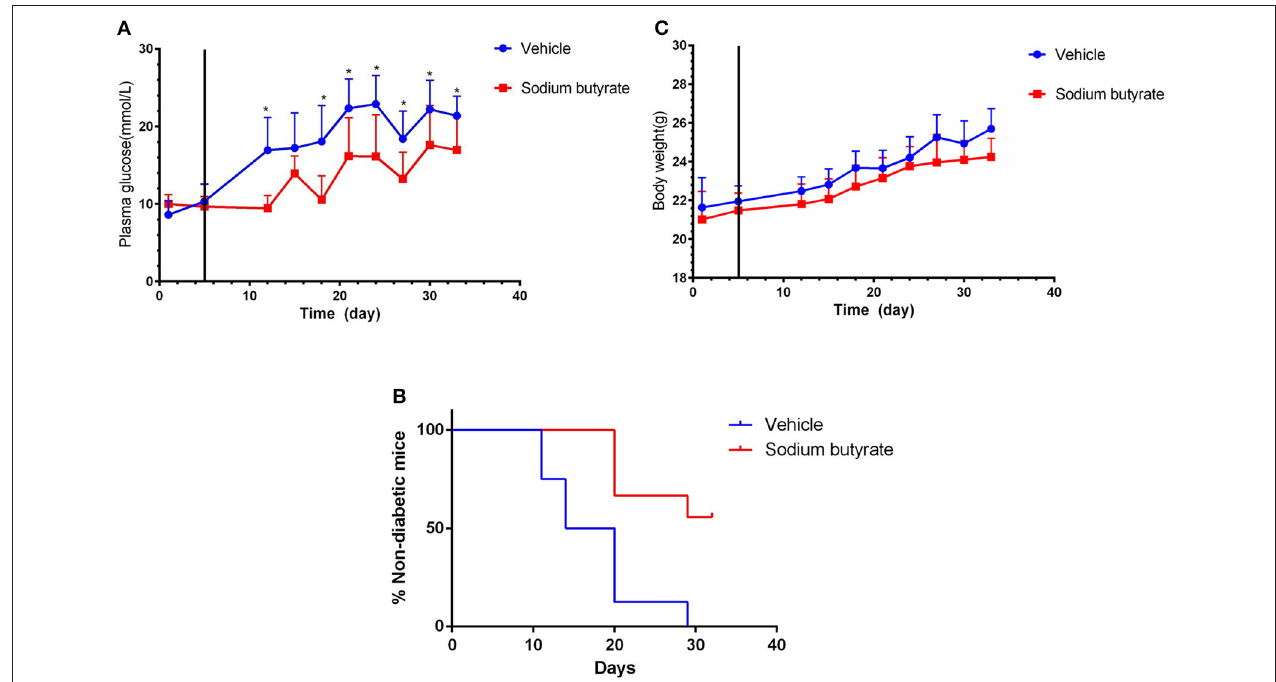
FIGURE 1 | Sodium butyrate treatment decreases blood glucose level and delays the onset of diabetes. Male BALB/c mice received STZ treatment by i.p. route at a dose of 40 mg/kg/day for 5 consecutive days. Sodium butyrate (dose of 500 mg/kg/day, n = 9) or vehicle treatment ( n = 8) from day 6 (solid line labeled) for 7 consecutive days after the last STZ injection. (A) STZ induced diabetic mice exhibited lower blood glucose when receiving sodium butyrate treatment compared with vehicle from day 11 (* p < 0.05). (B) Treatment with sodium butyrate decreased diabetes incidence and delayed the onset of diabetes (* p < 0.01). (C) Sodium butyrate treatment had no effect on the body weight of the diabetic